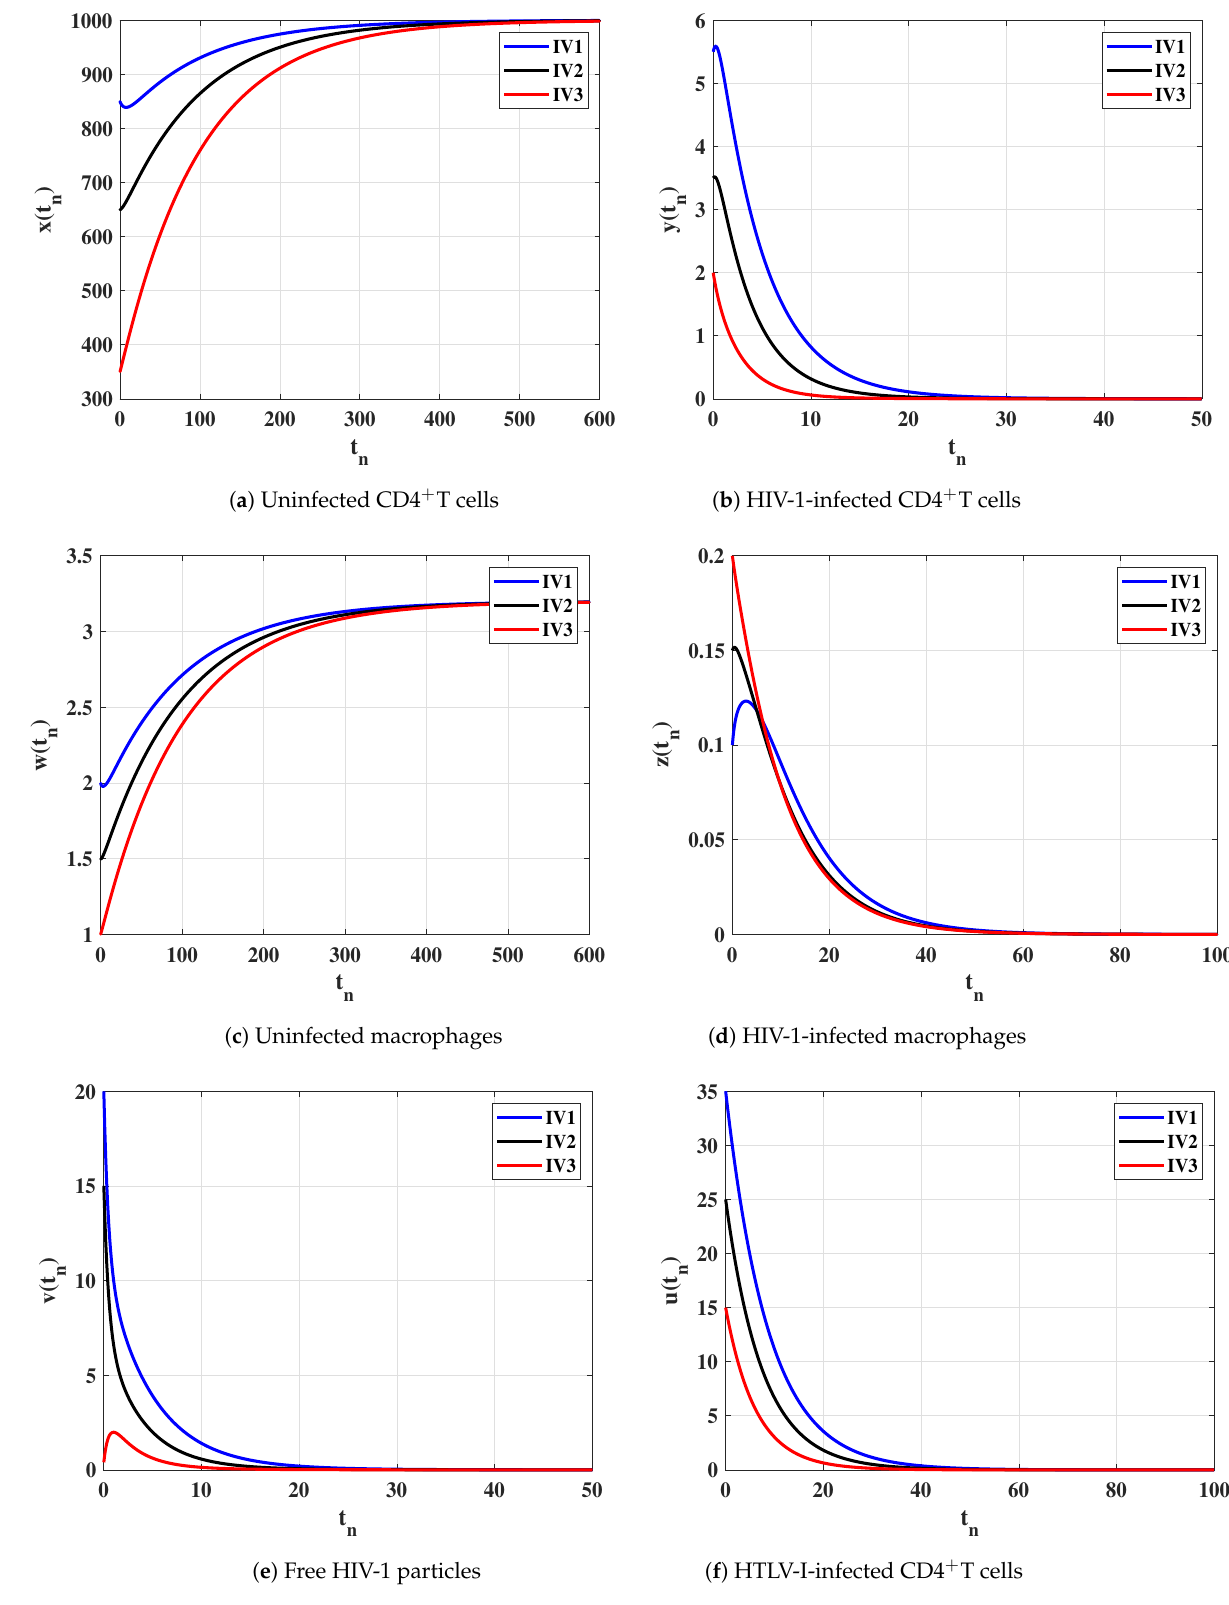
Figure 1. Solutions of model (10)–(15) with initial conditions IV1–IV3 in case of R 0 ≤ 1 and R 1 ≤